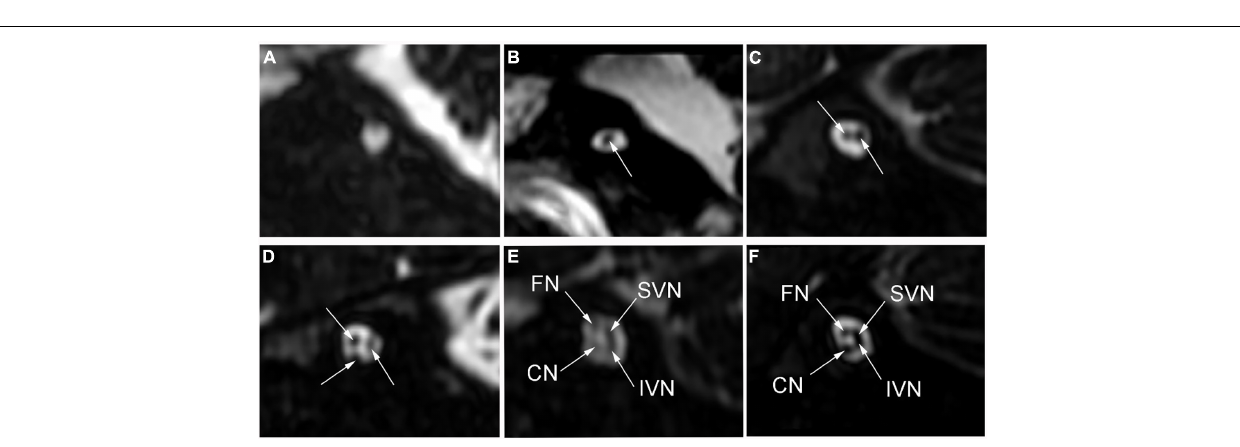
FIGURE 2 | The number of nerve bundles (indicated by the white arrows) in the internal auditory canal on oblique sagittal magnetic resonance imaging. (A) No nerve bundle, (B) one nerve bundle, (C) two nerve bundles, (D) three nerve bundles, (E) four nerve bundles (thin), (F) four nerve bundles (normal); CN: cochlear nerve, FN: facial nerve, IVN: inferior vestibular nerve, SVN: superior vestibular